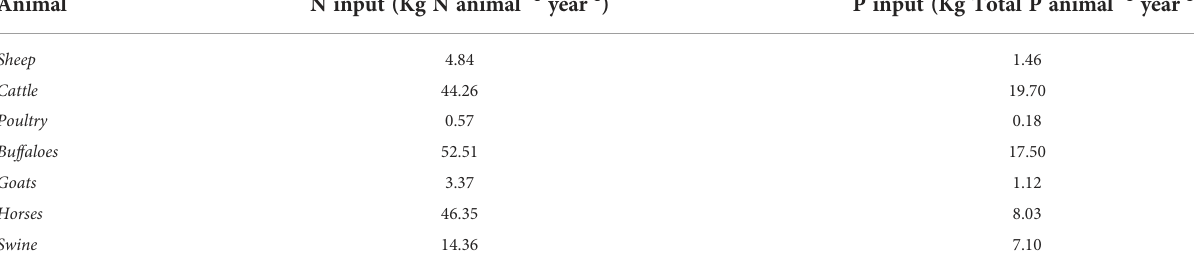
TABLE 3 Nutrient ’ s export coef fi cients to estimate inputs from livestock manure